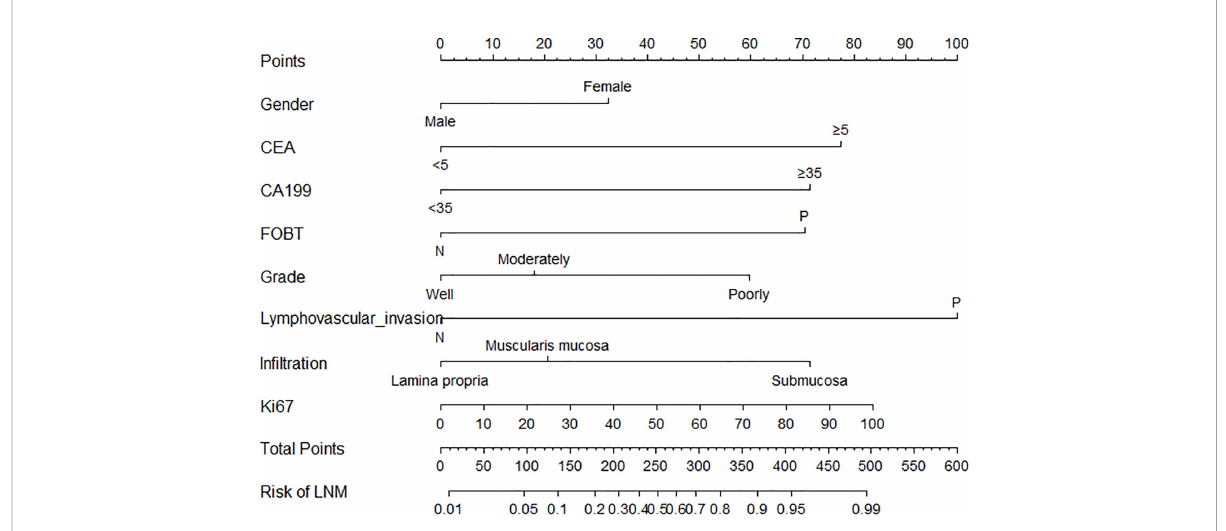
FIGURE 2 Nomogram for the prediction of lymph node metastasis after endoscopic submucosal dissection in early gastric cancer. LVI, lymphovascular invasion; FOBT, fecal occult blood